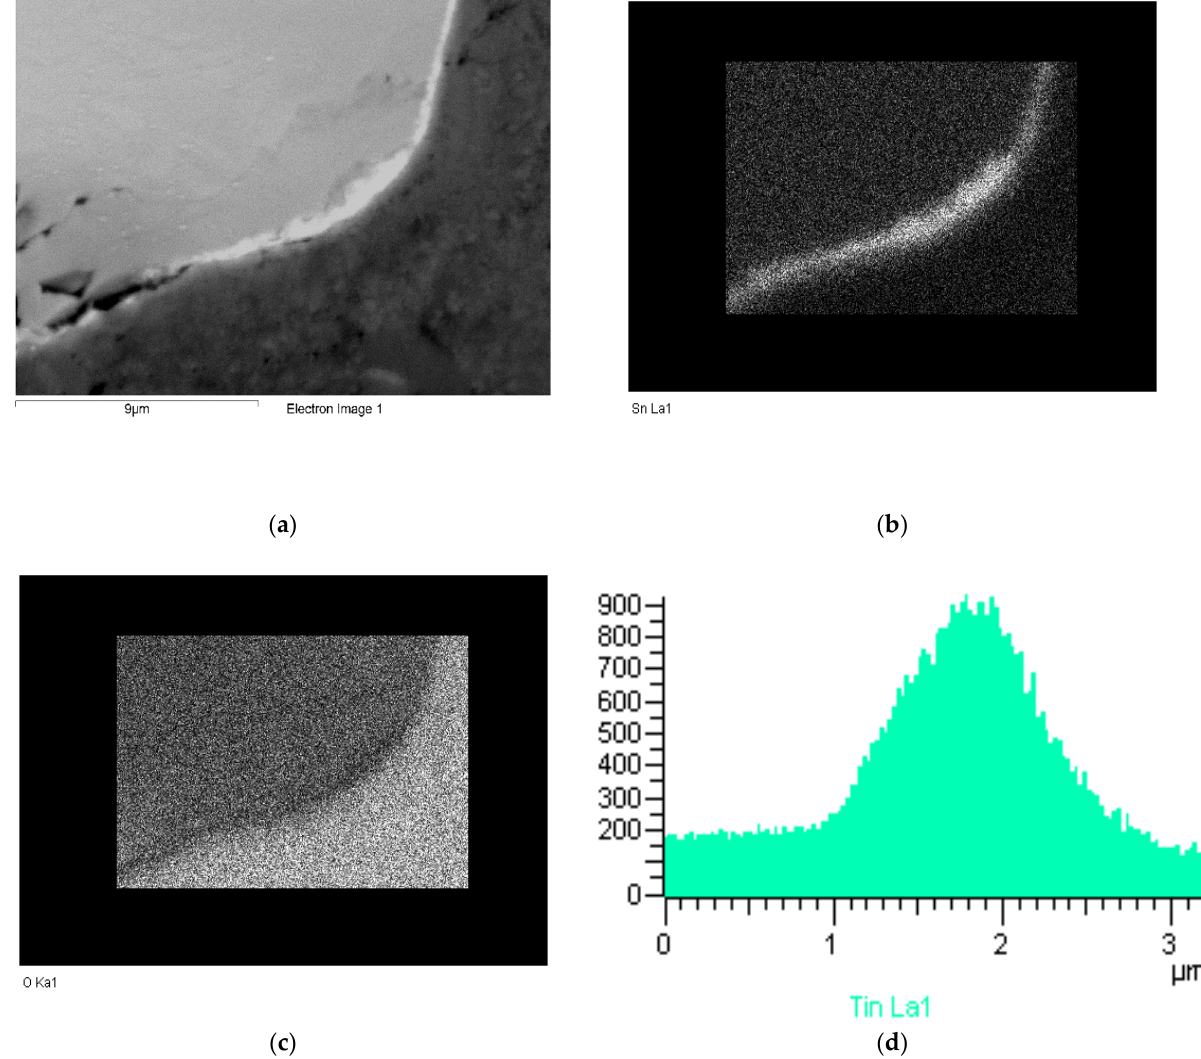
Figure 8. ( a ) Bright contrast layer at the interface between oxide scale and substrate. ( b ) Sn X-ray map. ( c ) Oxygen X-ray map. ( d ) Line scan showing thin layer to be rich in Sn.